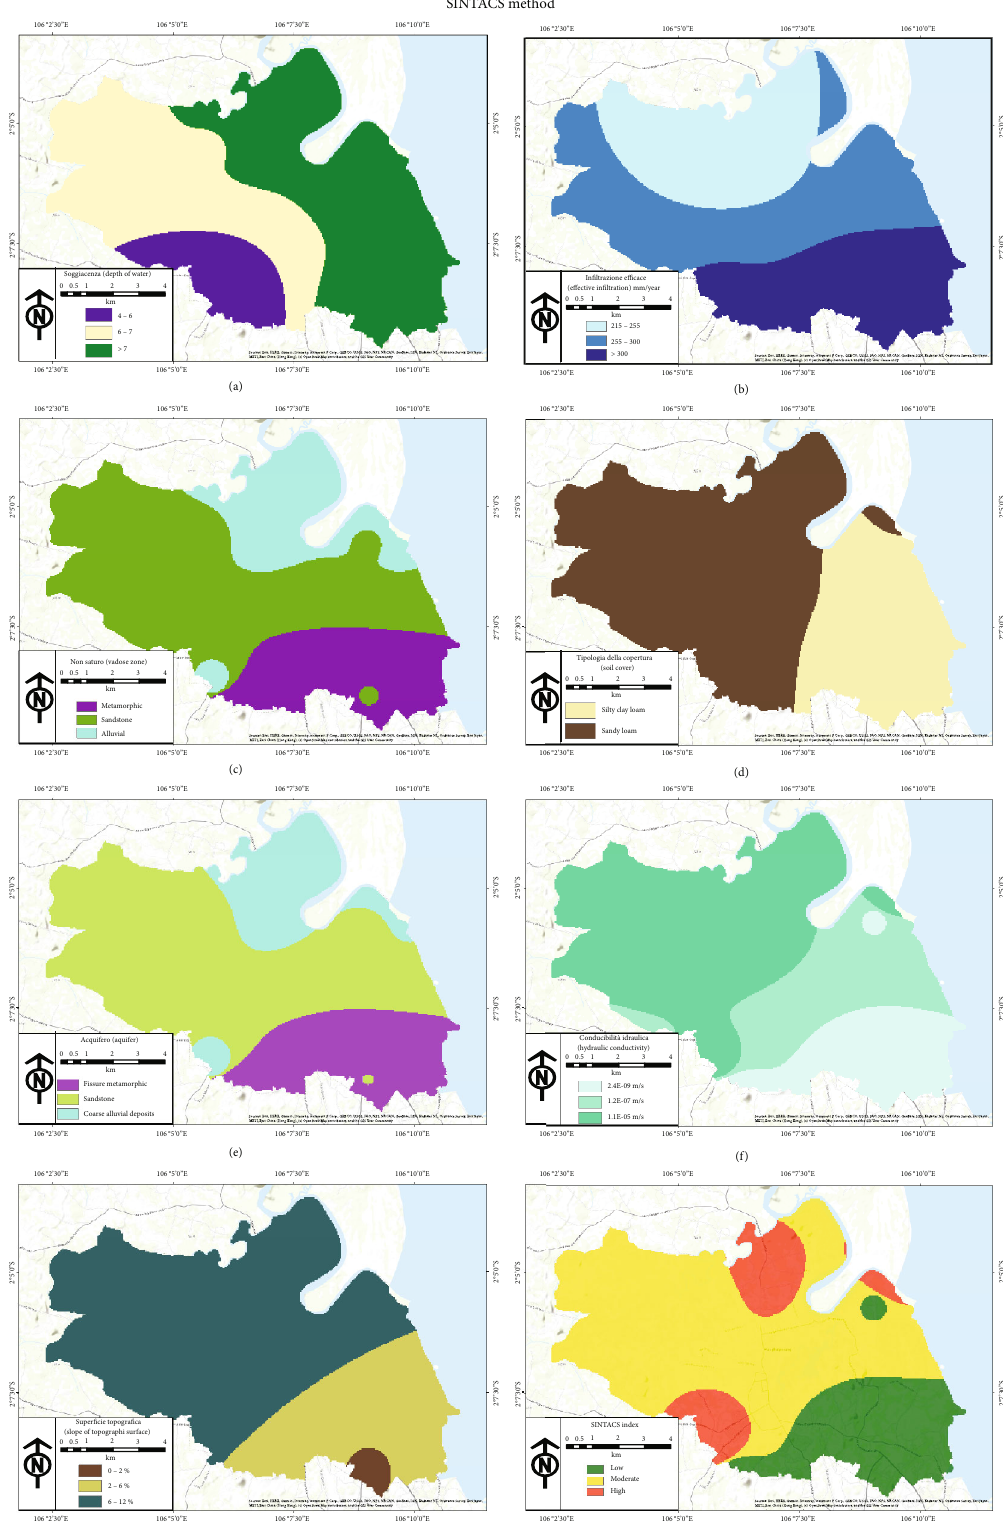
Figure 10: SINTACS method: (a) soggiacenza (depth of water); (b) in fi ltrazione e ffi cace (e ff ective in fi ltration); (c) non saturo (vadose zone); (d) tipologia della copertura (soil cover); (e) acquifero (aquifer); (f) conducibilità idraulica (hydraulic conductivity); (g) super fi cie topogra fi ca (slope of topographic